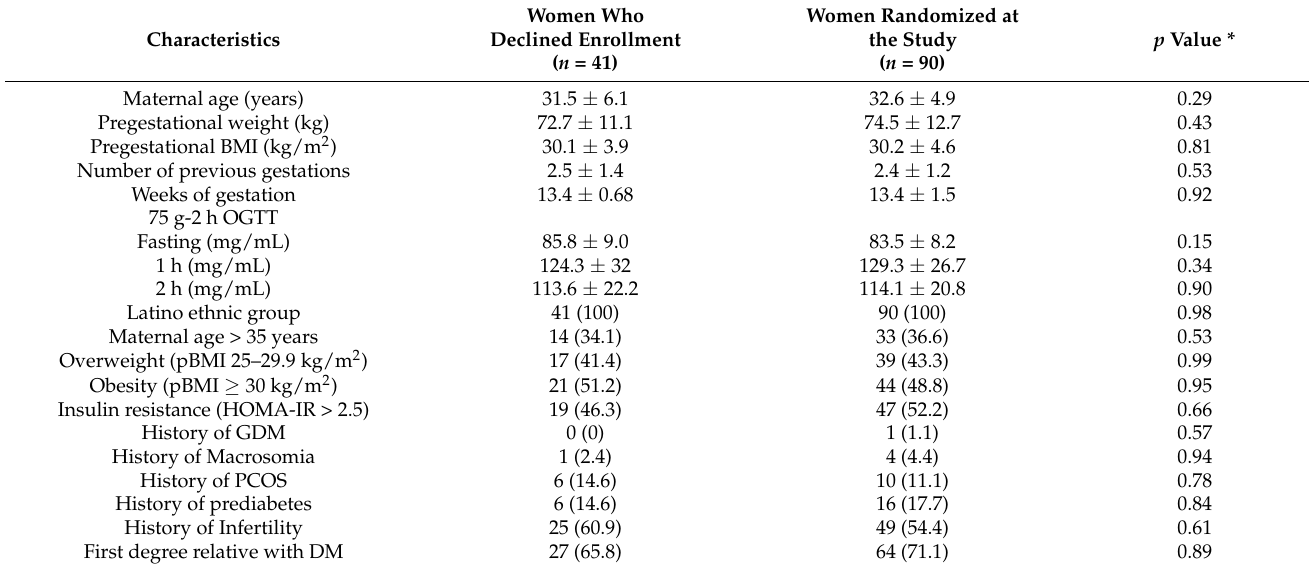
Table 2. Baseline characteristics and risk factors of pregnant women who declined enrollment after oral glucose tolerance test versus women who were randomized to the